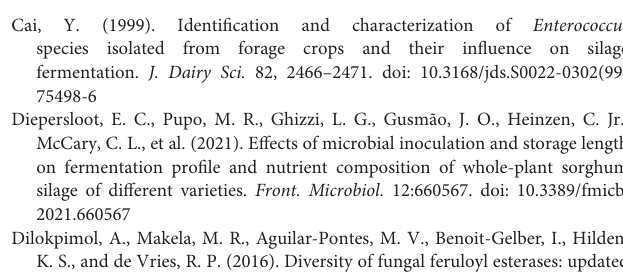
Supplementary Figure 1 | Redundancy analysis of the bacterial community (top 10 genera) and fermentation quality of alfalfa silage ( n = 4). Supplementary Figure 2 | Relative abundance of the bacterial community (family level) in alfalfa silage ( n = 4). Supplementary Figure 3 | Relative abundance of potentially pathogenic bacteria in alfalfa silage ( n = 4). Supplementary Figure 4 | Relative abundance of the bacterial community (species level) in alfalfa silage ( n = 4). Supplementary Table 1 | Relative abundance of lactic acid bacteria (species level) in alfalfa silage ( n =